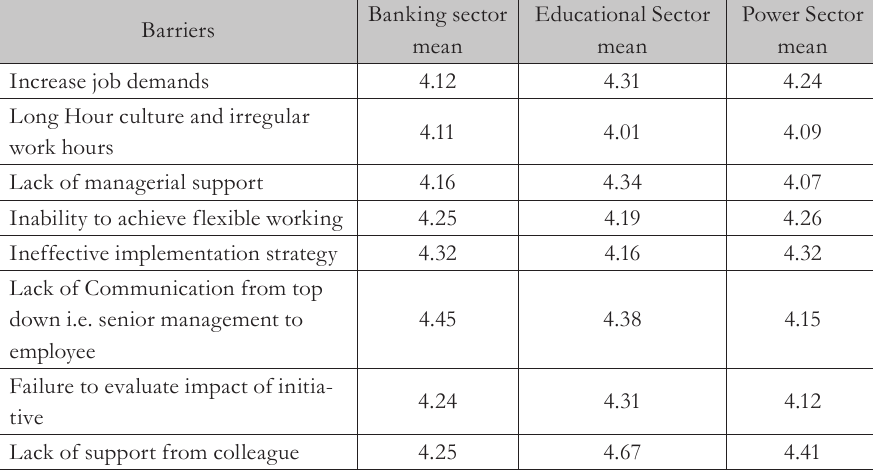
Tab. 4 - Barriers to WLB initiatives. Source: Field Survey,